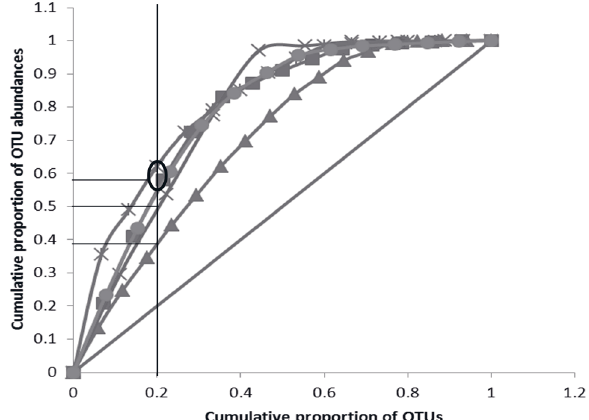
Figure 3. PL curves representing from Week 0 to Week 4 oftreatment C (seawater + BH medium + weathered crude oil + consortia). (“ ” Perfect evenness line; “ ” C (Week 4); “ ” C (Week 3); “ ” C (Week 2);“ ” C (Week 1);“ ” C (Week 0)).Oval represents a grouping of curves (more than one) and horizontal line without oval represents asingle PL